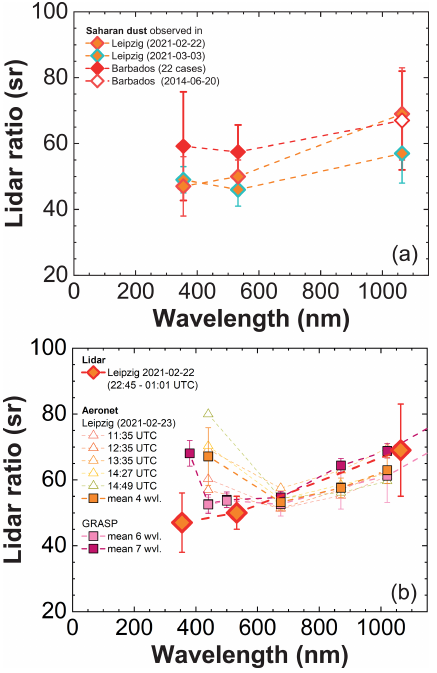
Figure 5. (a) Spectral dependence of the particle linear depolariza- tion ratio (PLDR) of desert dust. The Leipzig observations are com- pared with triple-wavelength depolarization ratio measurements of Saharan dust and fresh dust available in the literature (Ha17 – Haarig et al., 2017; Fr09 – Freudenthaler et al., 2009; Bu15 – Burton et al., 2015; and Hu20 – Hu et al., 2020; please note that the date format is year-month-day). (b) Spectral dependence of the PLDR of Saharan dust observed in the night of 22–23 Febru- ary 2021 compared with AERONET v3 inversion solutions for the PLDR on 23 February 2021. The results of the five photometer scans at indicated times are shown together with the mean of the four-wavelength retrieval (orange squares, standard retrieval) and the six- and seven-wavelength retrieval (pink and purple squares, GRASP method). The GRASP retrieval at 1640nm (not shown) leads to PLDR values of 0.184 ± 0.007 (using six wavelengths) and 0.192 ± 0.008 (using seven